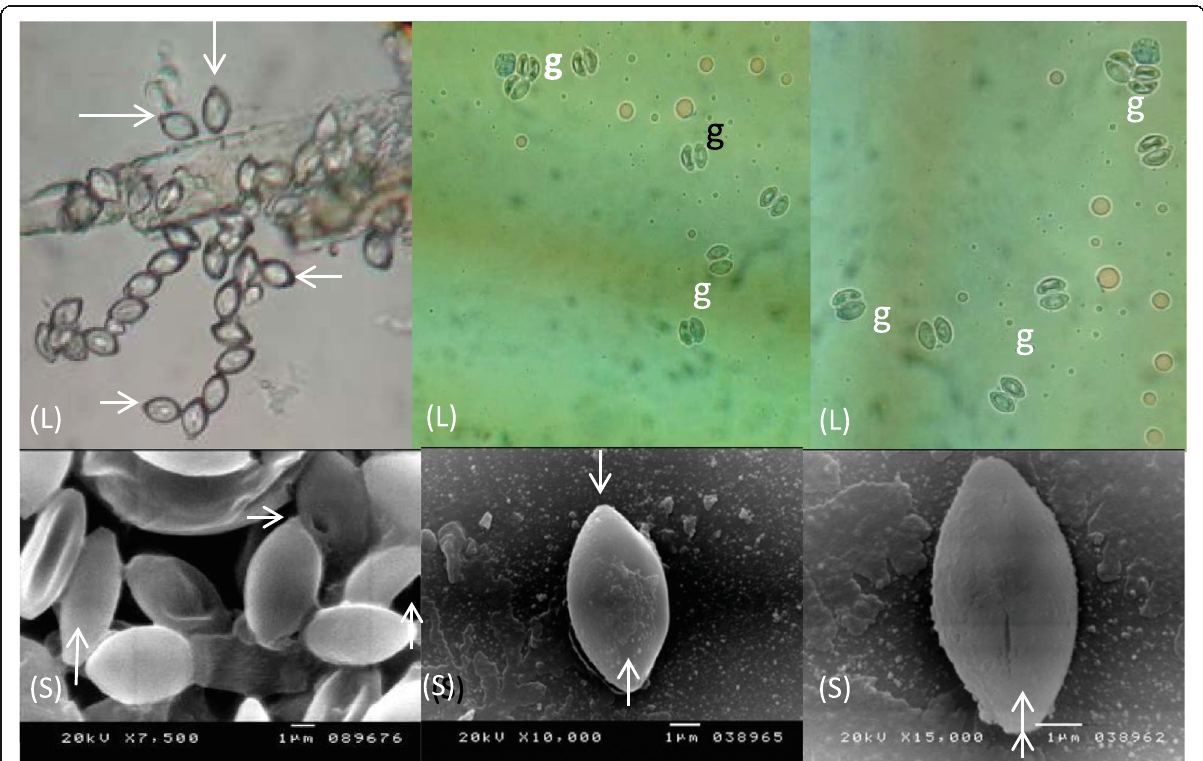
Fig. 2 Light (L) and scanning electron (S) microscope views of Mattesia. Note the navicula-shaped spores with polar plugs (arrows) and spore pairs within a gamontocyst (g) (×400